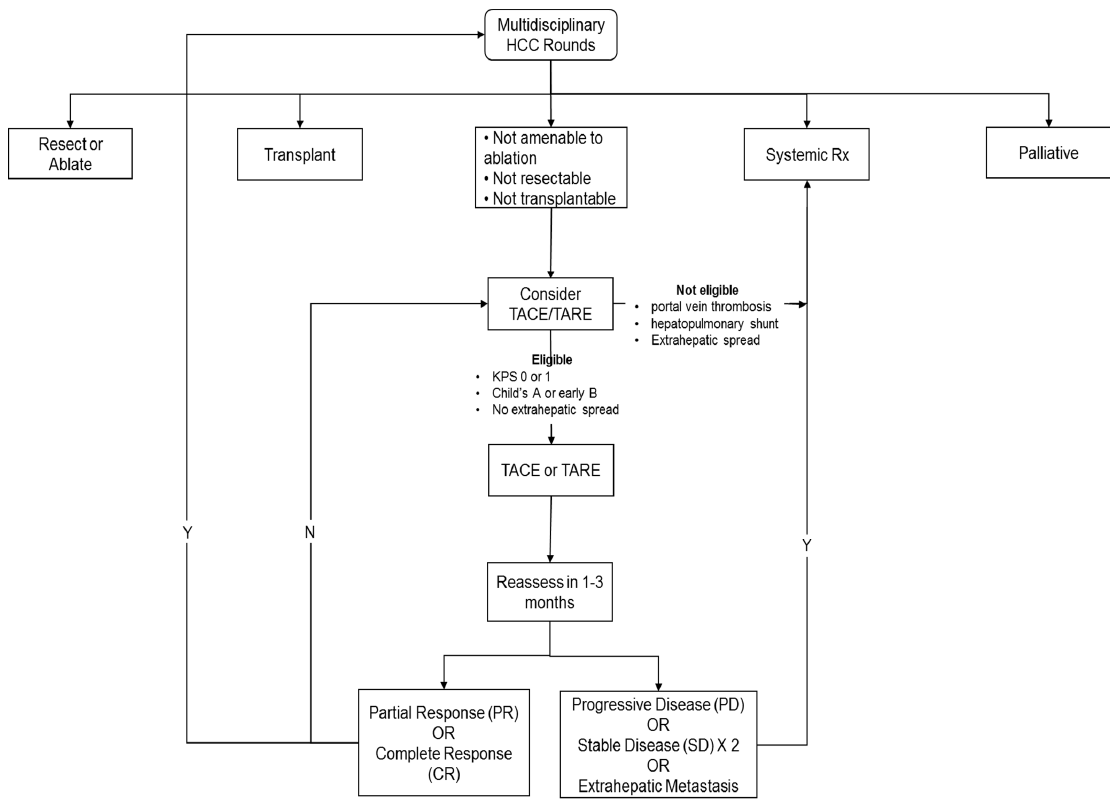
Figure 1. Local–regional therapy flow chart.